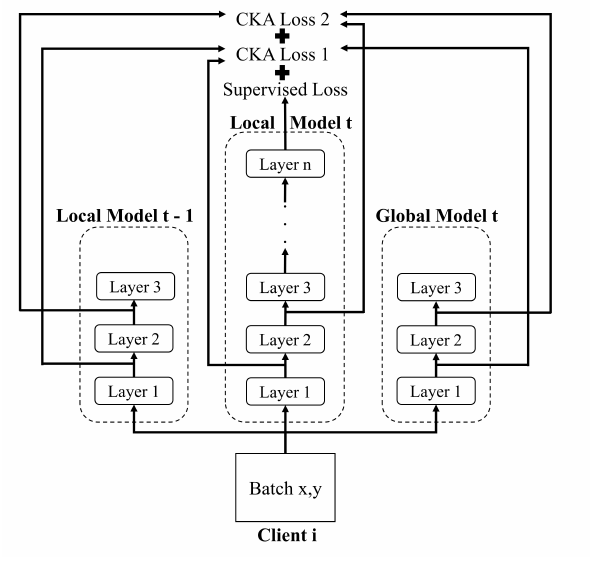
Figure 3. Training process of